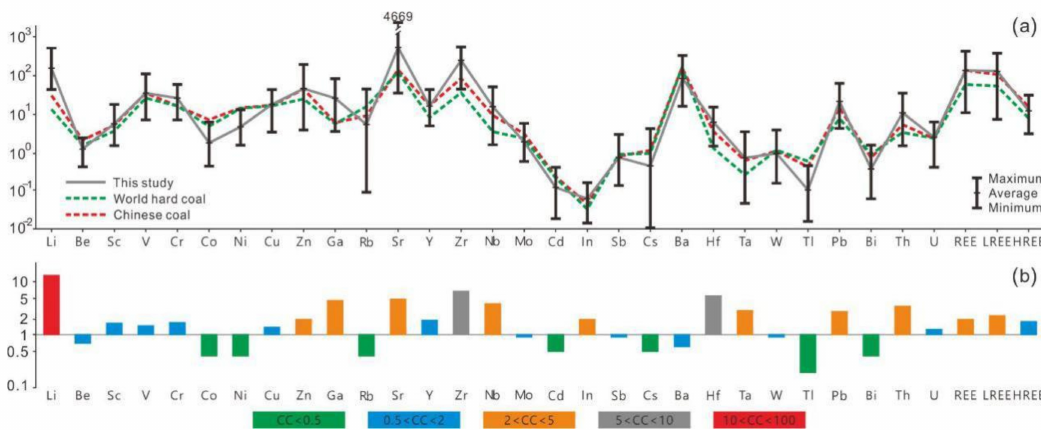
Figure 2. ( a ) Comparison of trace elements concentrations among No. 9 coals, the common Chinese coal [77] and the world hard coal [80], unit of ordinate was µ g/g. ( b ) Concentration coefficients (CC) of trace elements in No. 9 coals, normalized by the World hard coals